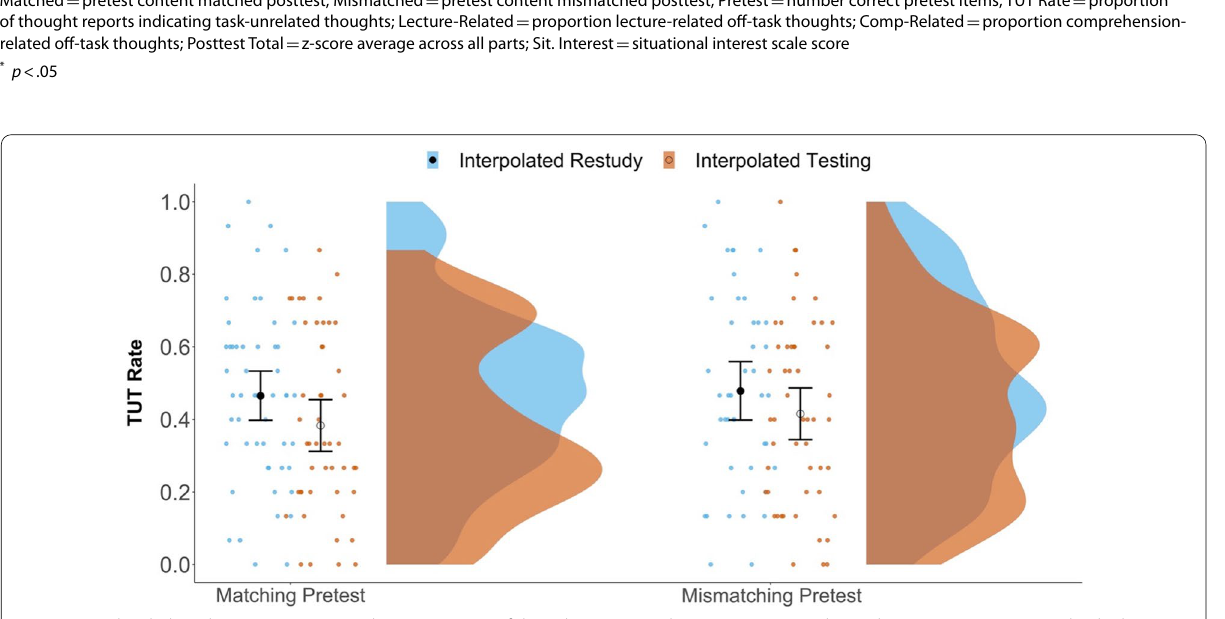
) for Primary Dependent Variables in Testing Versus Restudy Conditions 10